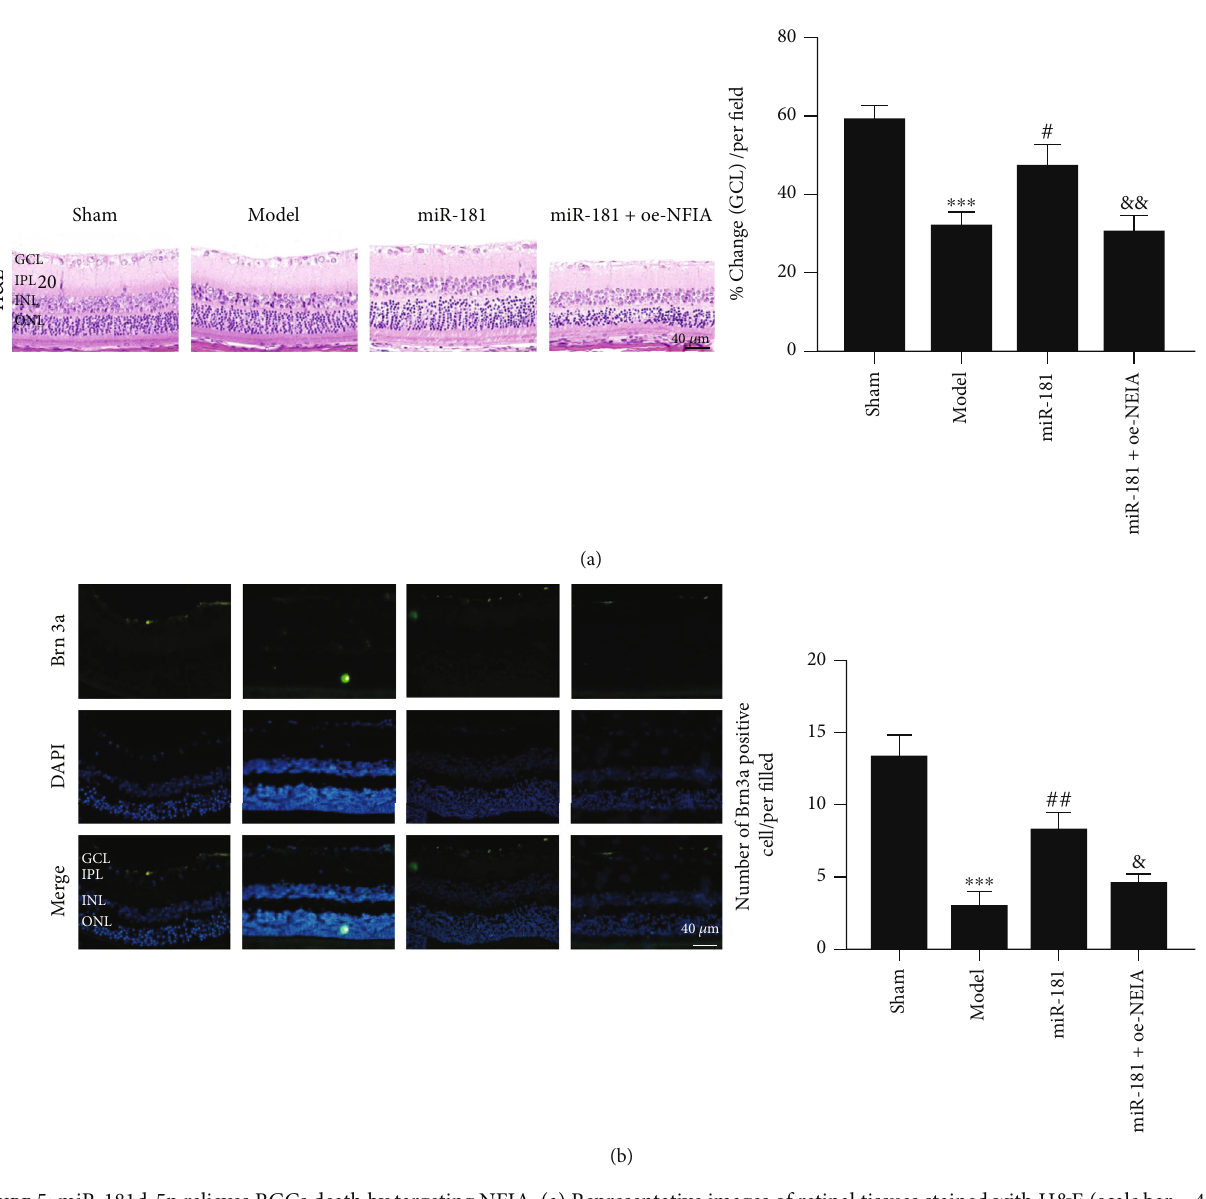
Figure 5: miR-181d-5p relieves RGCs death by targeting NFIA. (a) Representative images of retinal tissues stained with H&E ( scale bar = 40 μ m). (b) Representative images of POU-homeodomain transcription factor Brn3a staining ( scalebar = 40 μ m). ∗∗∗ P < 0 : 001 ; # P < 0 : 05 , ## P < 0 : 01 ; & P < 0 : 05 , && P < 0 : 01